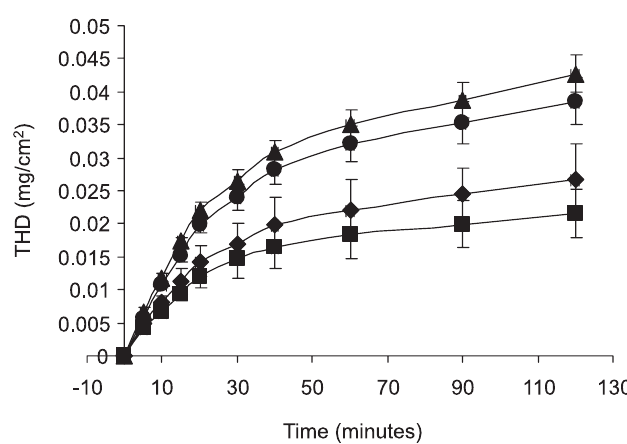
FIGURE 1 - In vitro release profiles of total hydroxycinnamic derivatives expressed as rosmarinic acid from starch/glycerol/ MOE films per cm 2 of film. Starch/glycerol/MOE; ( ¡ ) 90/0/10; ( · ) 80/10/10; ( — ) 70/20/10; ( p )